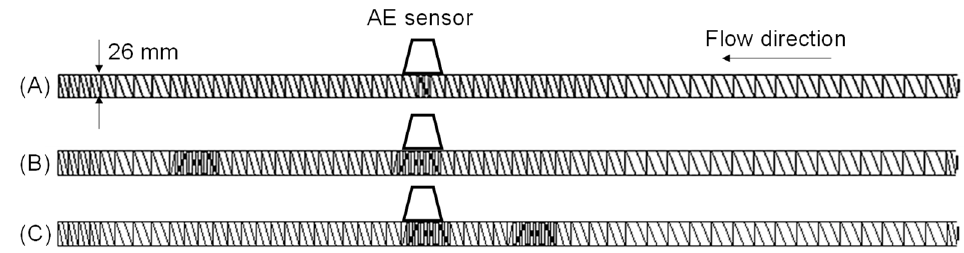
Figure 2. Screw configurations of ( A – C ) of the co-rotating twin-screw